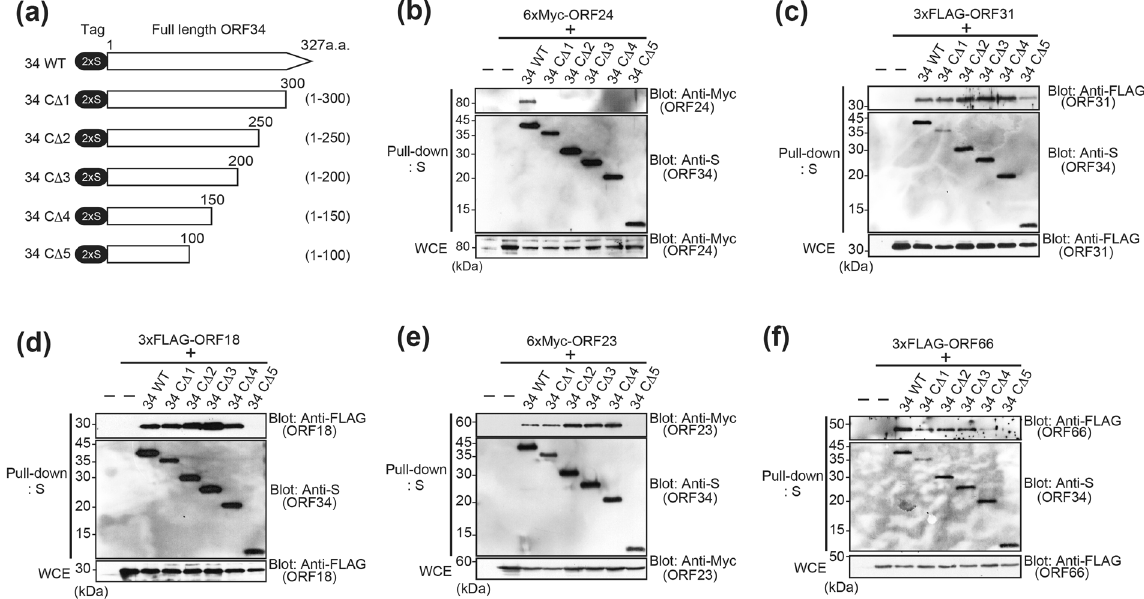
Figure 6. The central region of ORF34 is required for interactions with ORF18, ORF31, ORF23, and ORF66, while the C-terminal domain is required to interact with ORF24. ( a ) Schematic representation of 2xS-tagged ORF34 deletion mutants used in the mapping experiments. The end amino acids are numbered. ( b – f ) 293T cells were co-transfected with expression plasmids of 2xS-ORF34 mutant and 6xMyc-ORF24 ( b ), 3xFLAG-ORF31 ( c ), 3xFLAG-ORF18 ( d ), or 3xFLAG-ORF66 ( f ). Transfected cells were lysed, and cell lysates were subjected to pull-down assays using S-protein-immobilized beads that capture the 2xS-ORF34. Obtained precipitates including 2xS-ORF34 deletion mutants were probed with indicated antibodies to detect interaction. ( b – f ) Original images of blotting data are shown in Supplementary Figs S10–S14.